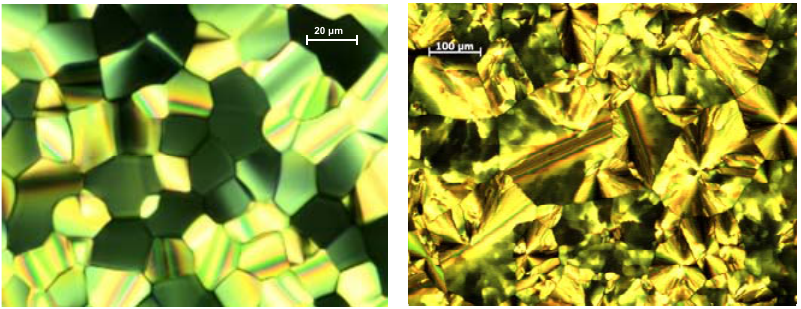
Figure 12. Textures of liquid crystal phases between crossed polarizers. Left: Mosaic texture of compound 25e at 99 °C typically observed for columnar phases. Right: Texture of discotic lamellar phase of 25f at 88